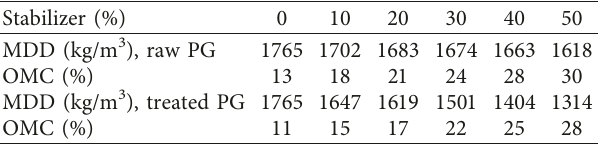
Table 3: MDD and OMC with raw and treated PG stabilizers.